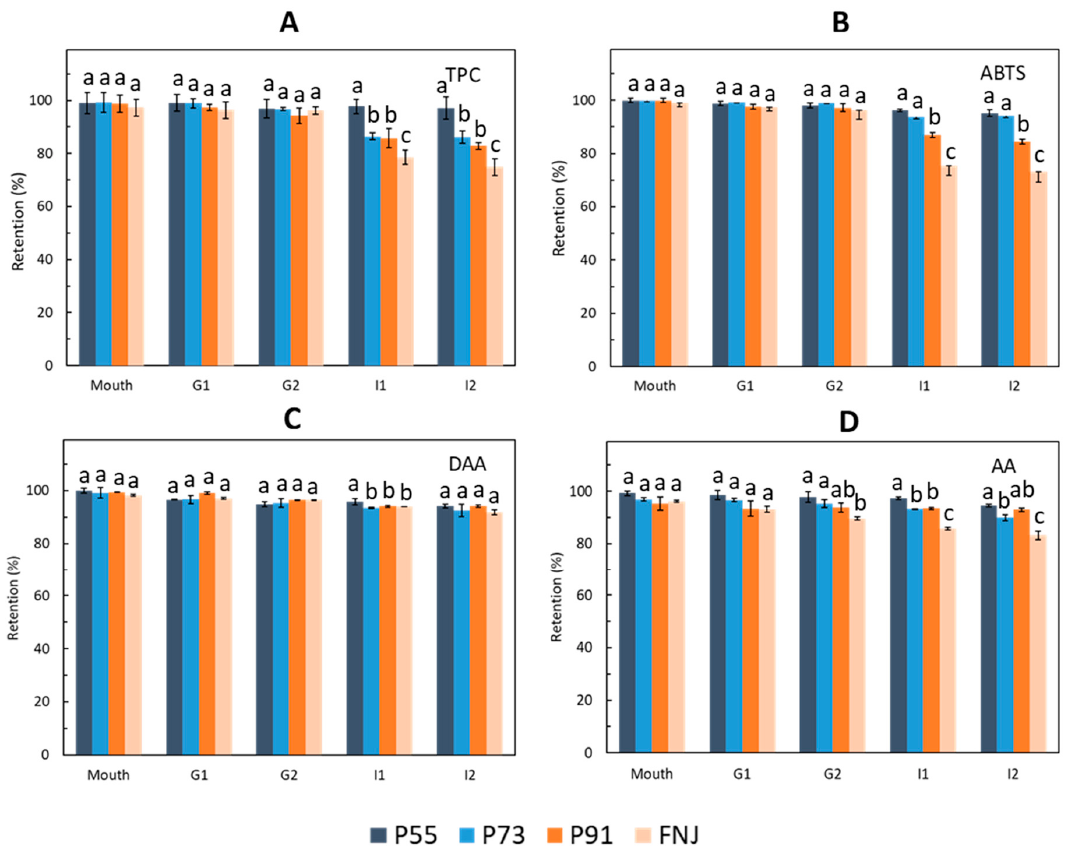
Figure 5. Retentions of TPC ( A ), antioxidant capacity ( B ) and iridoids contents ( C , D ) in spray-dried powders at different stages during in vitro digestion. DAA: deacetylasperulosidic acid; AA: asperulosidic acid; G1 and G2: after simulated gastric digestion for 1 and 2 h; I1 and I2: after simulated intestinal digestion for 1 and 2 h; P55, P73 and P91: powders produced using maltodextrin and gum acacia as carriers with the blended ratios of 5:5, 7:3 and 9:1. FNJ: fermented noni juice. The bars with different letters at the same in vitro digestion stage are significantly different ( p < 0.05).